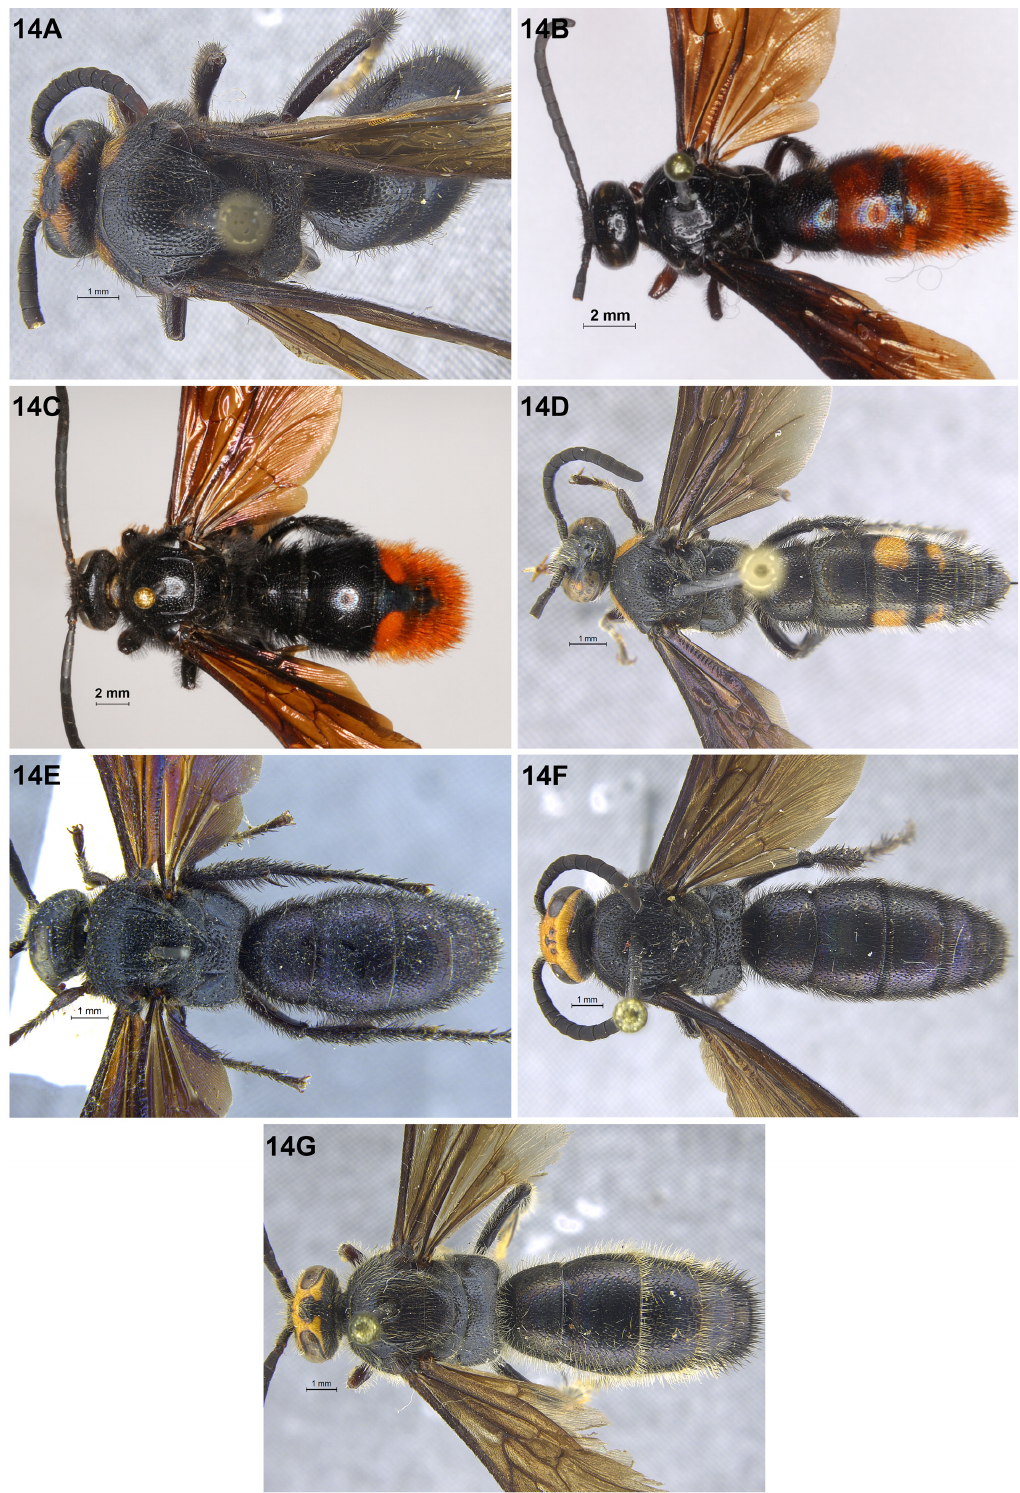
Fig. 14. Males, dorsal habitus. A . Carinoscolia junnanensis (Betrem, 1928). B . Liacos erythrosoma (Burmeister, 1854). C . Megascolia azurea (Christ, 1791). D . Scolia binotata Fabricius,